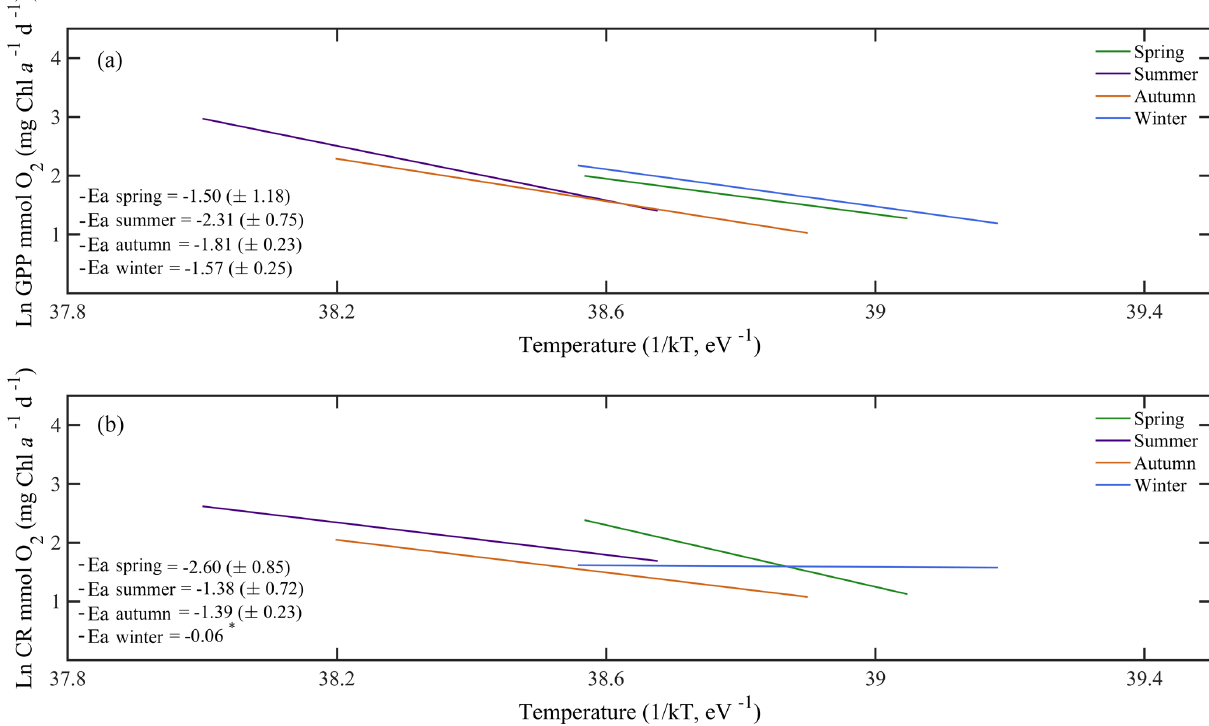
Figure 8. Arrhenius plots indicating the seasonal temperature dependence of planktonic metabolic rates plotted as the relationship between the natural logarithm of (a) chlorophyll a -normalised gross primary production and (b) planktonic community respiration with temperature as a function of 1 /kT (lower axis), where k is the Boltzmann’s constant (8 . 2 × 10 − 5 eVK − 1 ), and T denotes the absolute temperature (K). Each line represents the linear least square fit. E a represents the activation energy ( E a = negative